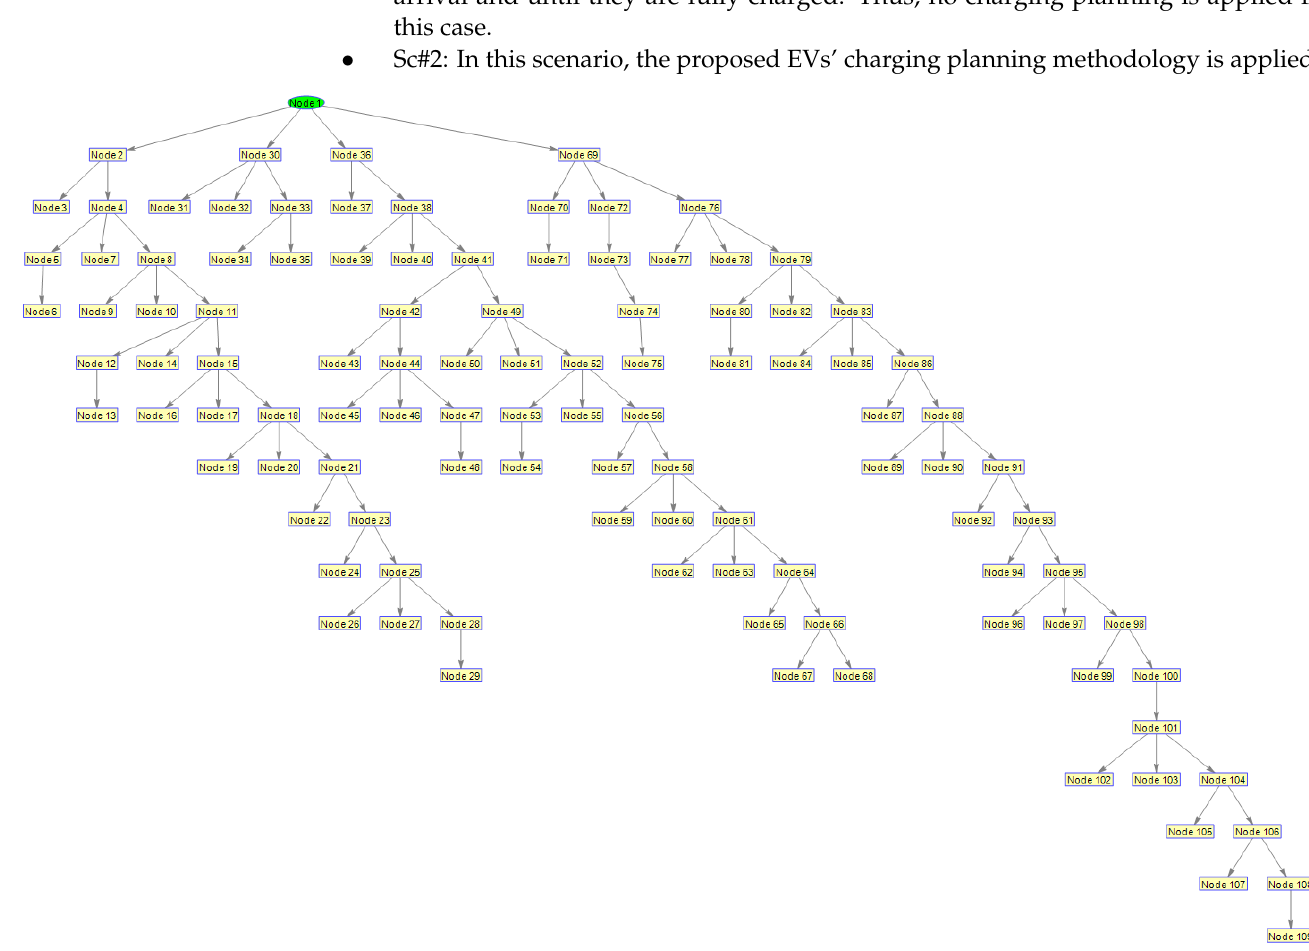
Figure 3. Low-voltage distribution network.